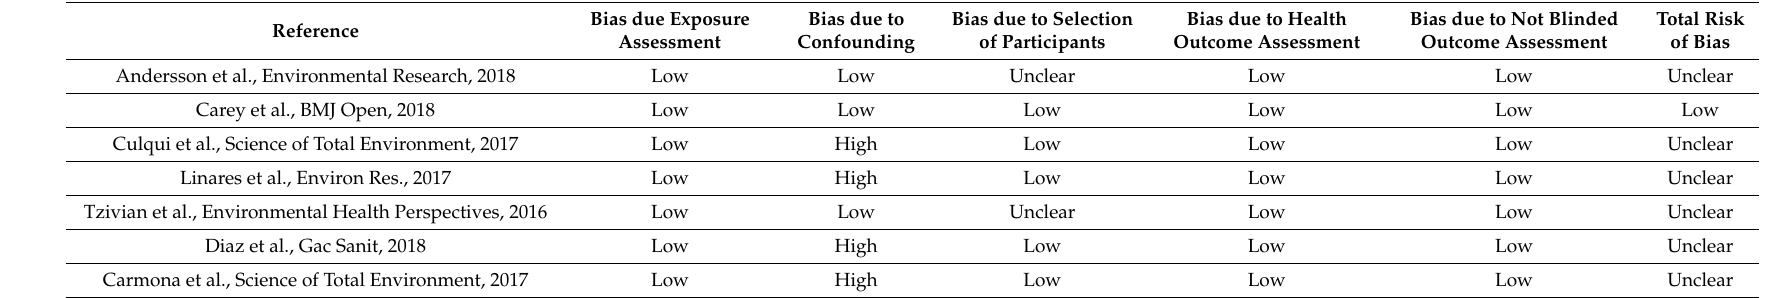
Table 4. Dementia and other neurodegenerative outcomes: risk of